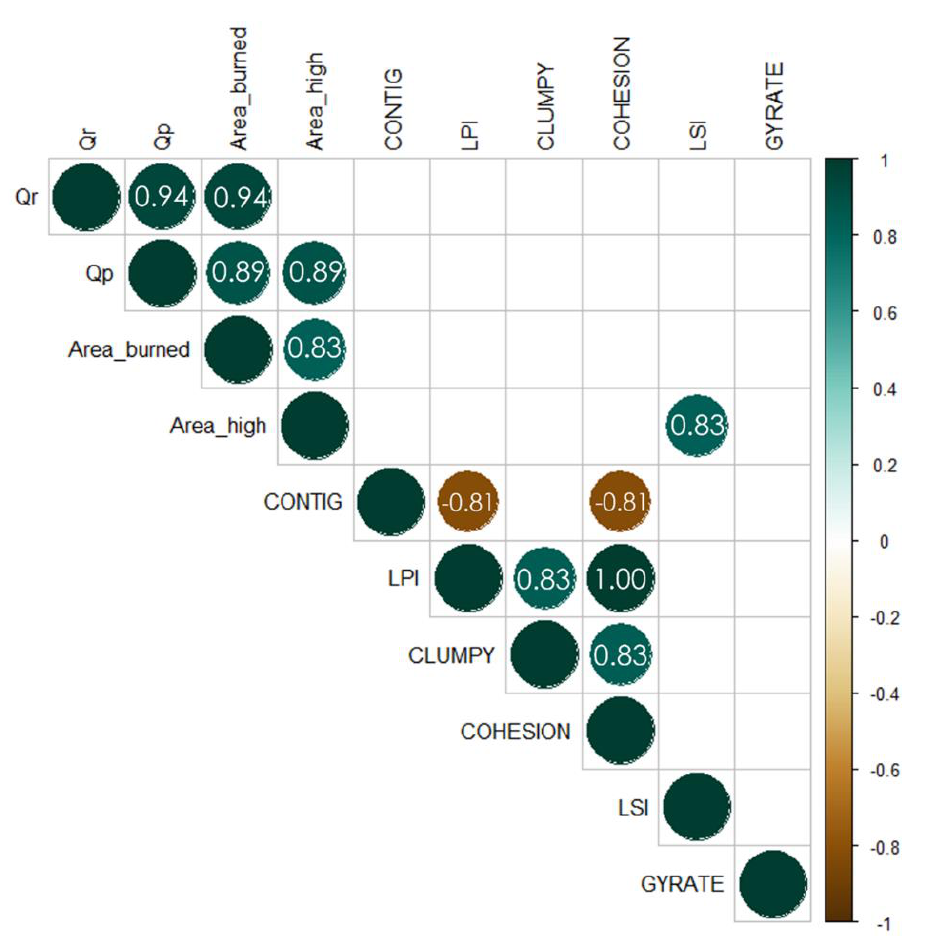
Figure 7. Spearman’s rank correlation (r s ) matrix for change in post-fire runoff coefficients to burned area landscape metrics. Only significant ( p -value < 0.05) correlation values are shown.